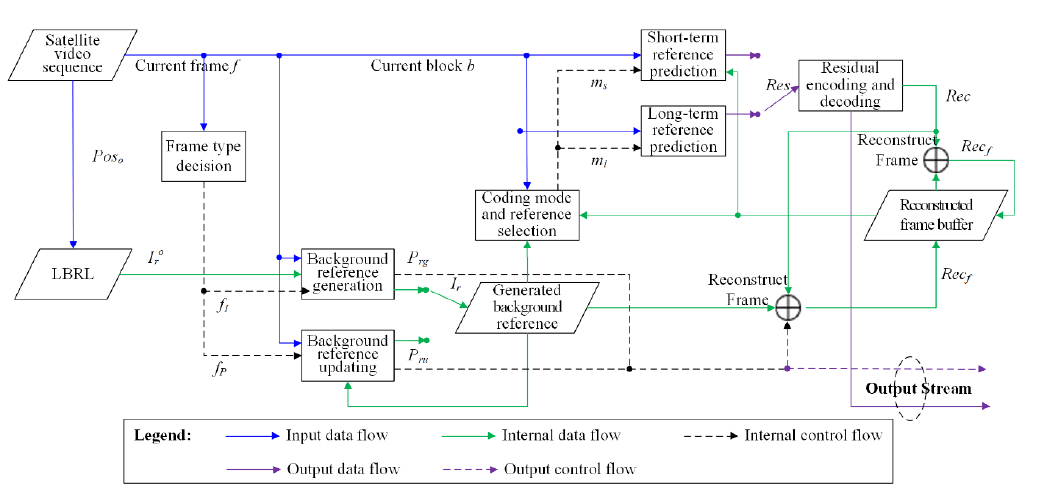
Figure 4. The overall framework of the LBRL-based encoding of EOVD.